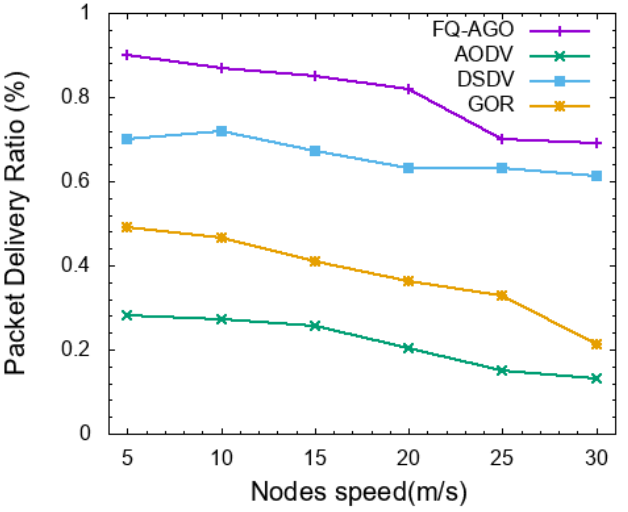
Figure 10. Packet delivery ratio (%) vs. nodes